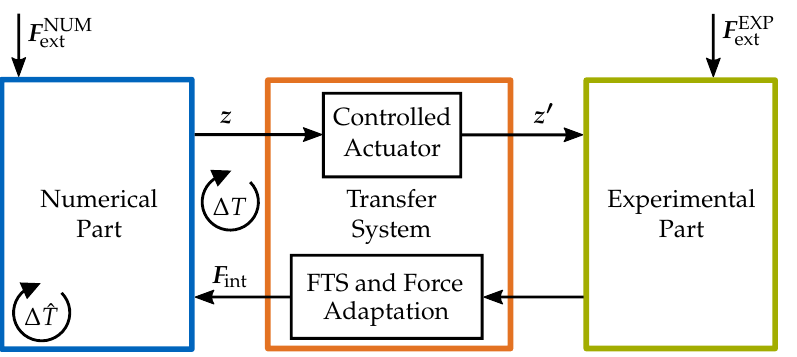
Figure 2. To couple the numerical (in blue) and experimental part (in green), a transfer system (in orange) is used. The transfer system consists of a controlled actuator, an FTS, and a DSP. The DSP is not visualized in the